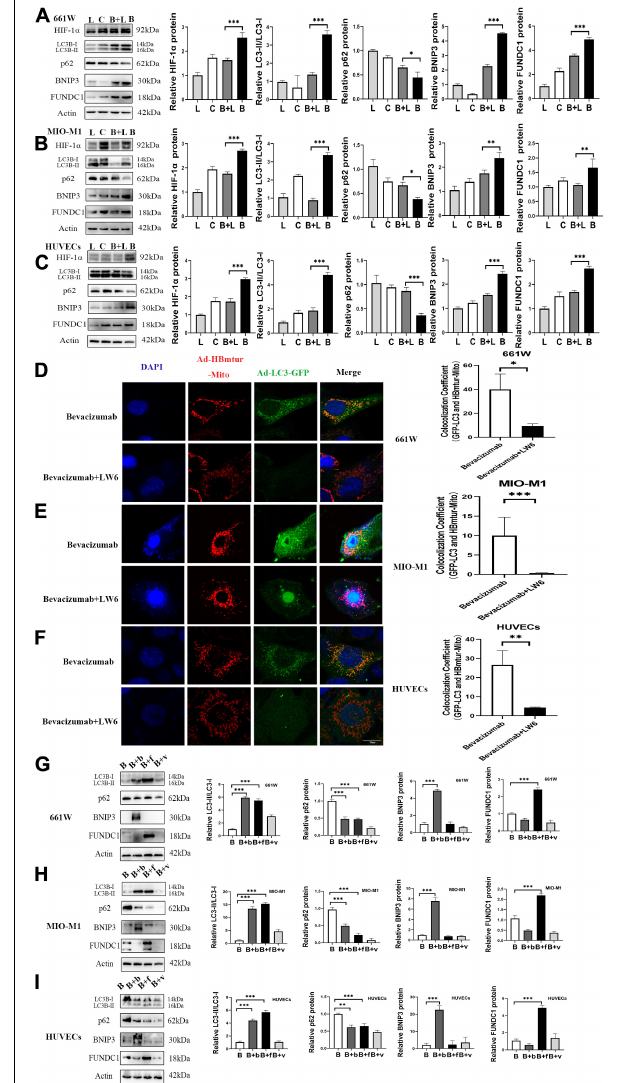
FIGURE 4 | A HIF-1 α -BNIP3/FUNDC1 signaling pathway mediated bevacizumab-induced mitophagy under hypoxia. (A–C)